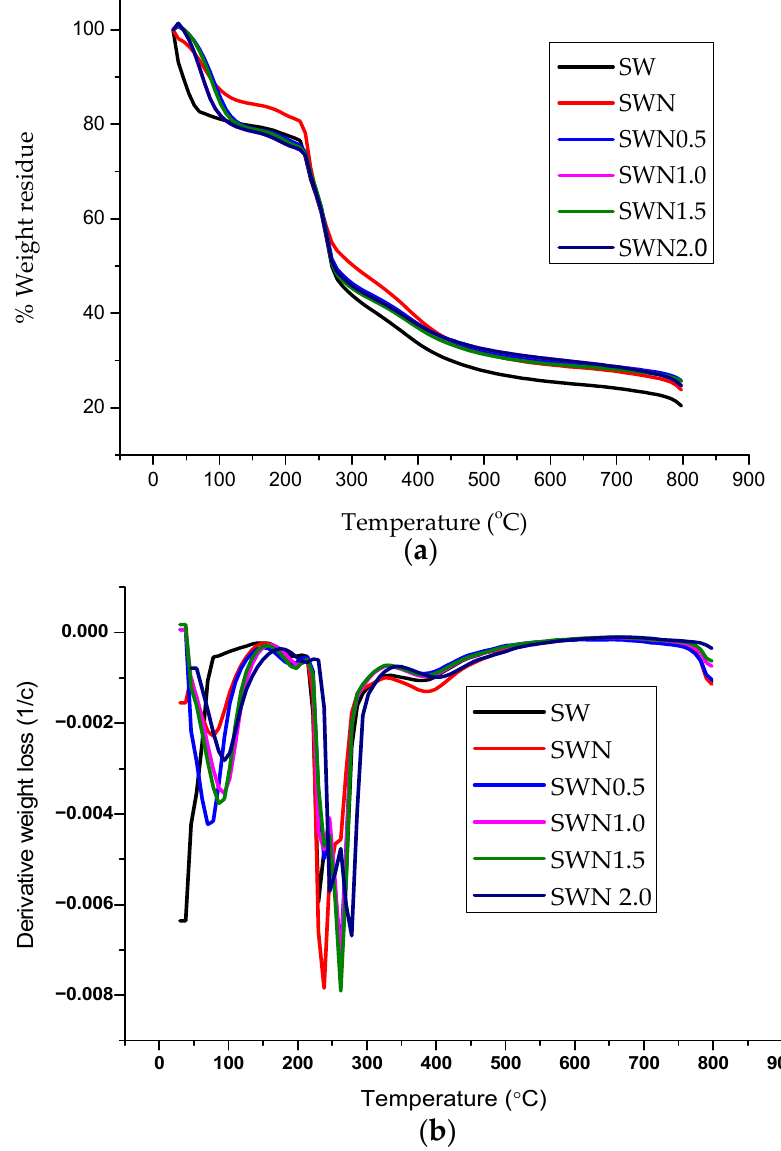
Figure 5. Thermal analysis indicating ( a ) TGA curve ( b ) DTG curve of the seaweed, seaweed-neem, and seaweed-neem irradiated films at different dosages.